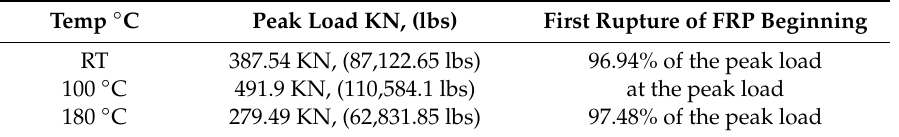
Table 10. Comparison of failure load and first rupture beginning for FRP strengthened concrete columns at RT, 100 ◦ C and 180 ◦